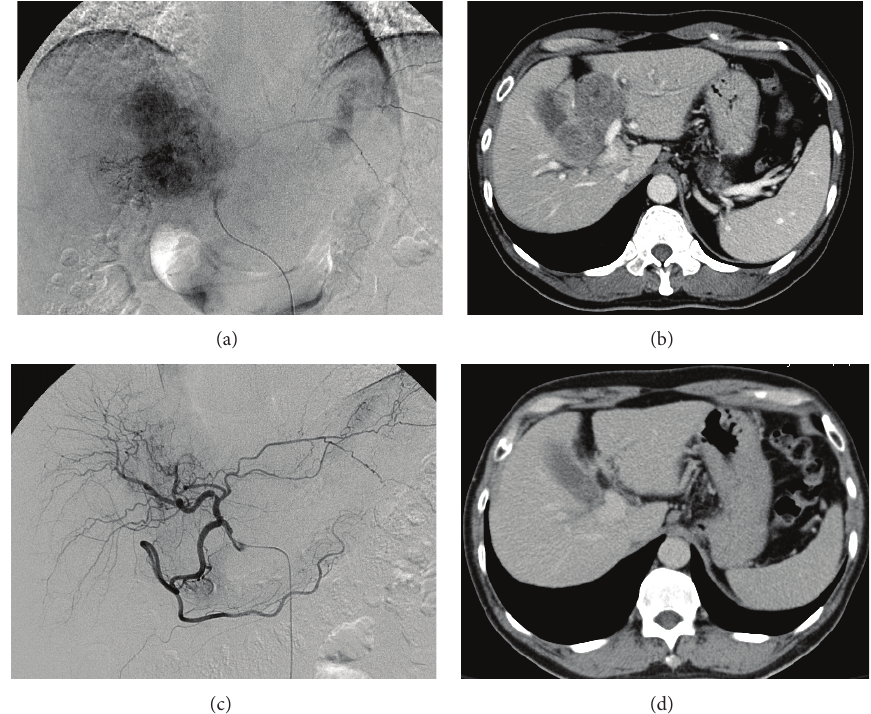
Figure 1: (a) Angiogram of the hepatic artery obtained before intra-arterial chemotherapy. (b) Computed tomography image of the liver obtained before intra-arterial chemotherapy. (c) Angiogram of the hepatic artery obtained after two cycles of intra-arterial chemotherapy. (d) Computed tomography image of the liver obtained after two cycles of intra-arterial chemotherapy.